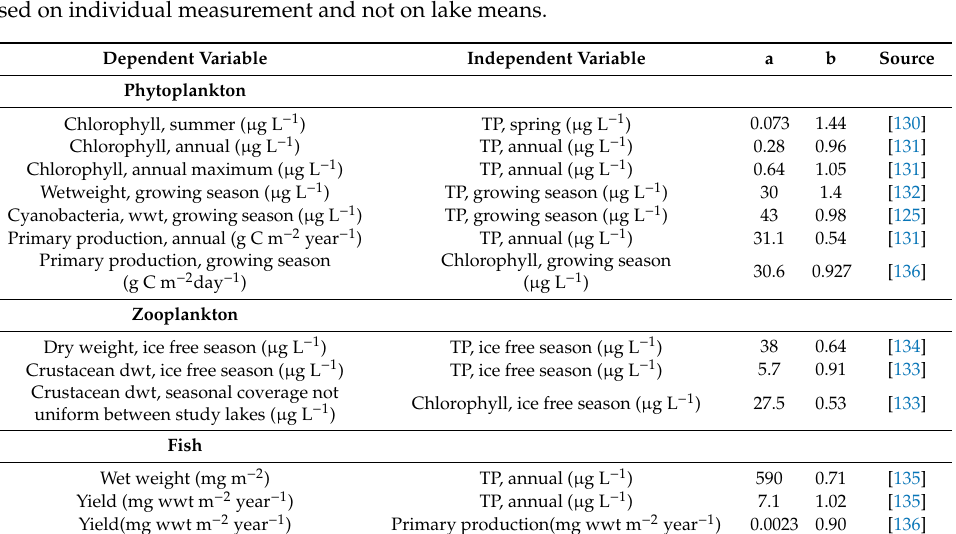
Table 1. Relationships between phytoplankton, zooplankton, fish and nutrient metrics: Taken from published multi-lake comparison according to the regression model y = a × x b . Values are mean values for the seasonal coverage indicated in the first two columns, except for one case where the annual maximum of chlorophy was used. The primary production–chlorophyll relationship by in [129] is based on individual measurement and not on lake